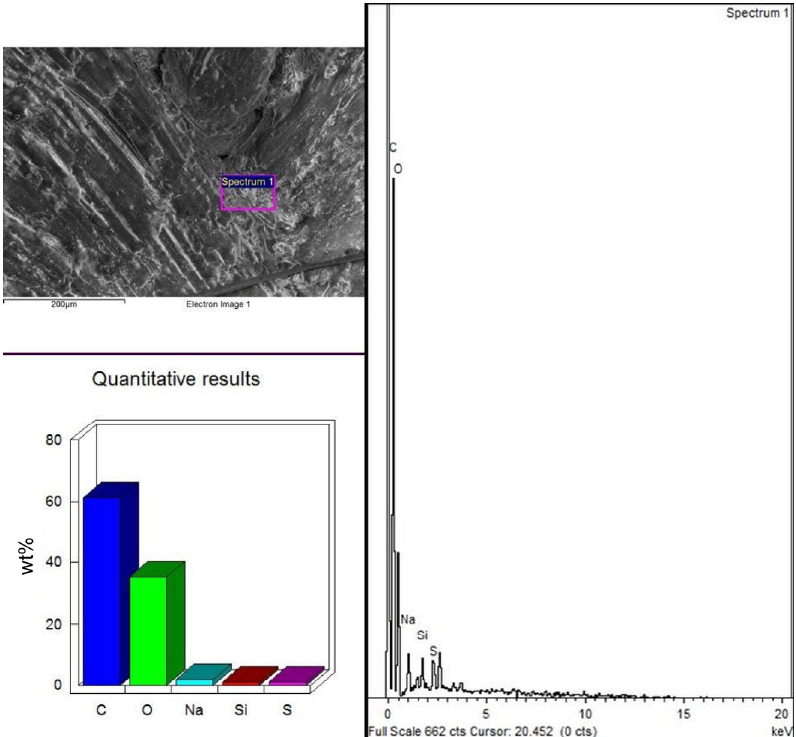
Fig. 12 SEM-EDS spectra of W-III